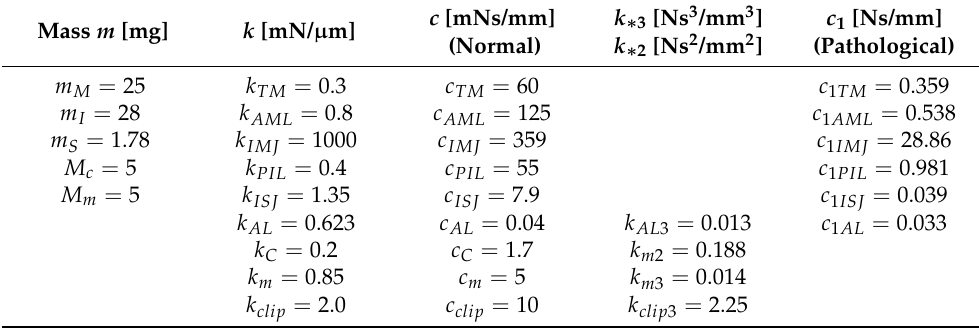
Table 1. Parameters of the middle ear model with the FMT taken from [14,17].